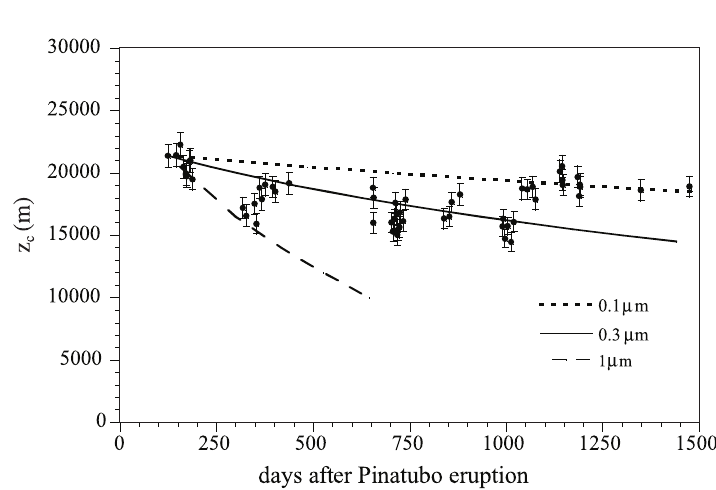
Fig. 5. Time evolution of z for the period 1991-1995. Also reported are the theoretical descent curves for 1 m m, c 0.3 m m and 0.1 m m diameter particles.